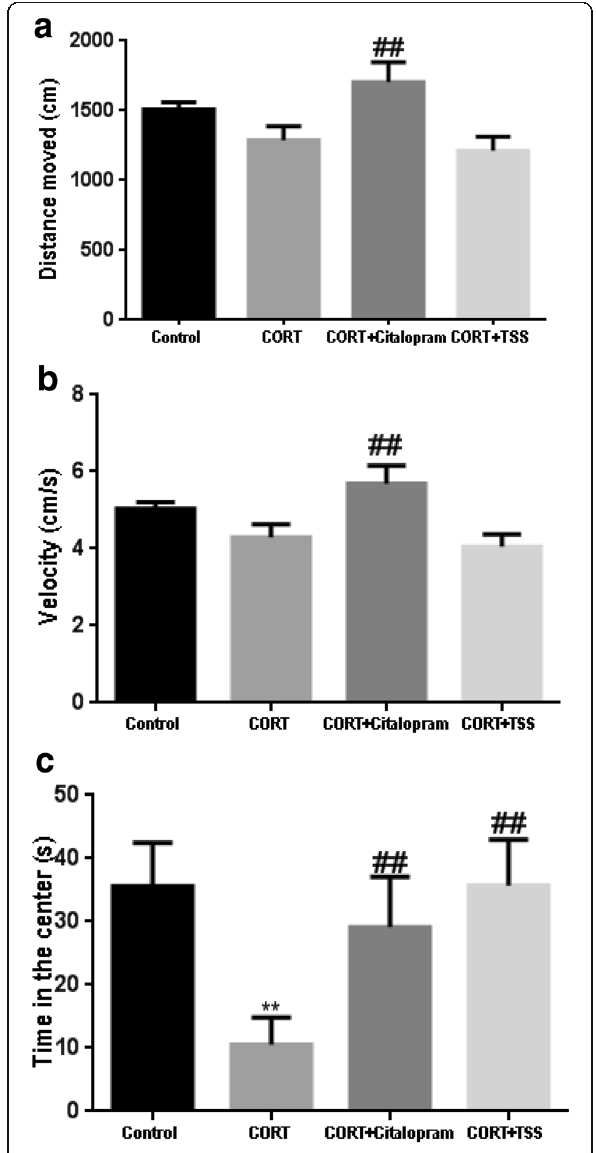
Fig. 3 Effects of TSS (25 mg/kg) and citalopram (10 mg/kg) on the OFT in the chronic CORT treatment mice. a Distance moved. b Velocity. c Time in the center. Data were analyzed by one-way ANOVA followed by Student-Newman-Keuls test. Each bar represents the mean ± SEM ( n = 8 – 9). ** P < 0.01, as compared with the control group and ## P < 0.01, as compared with the CORT